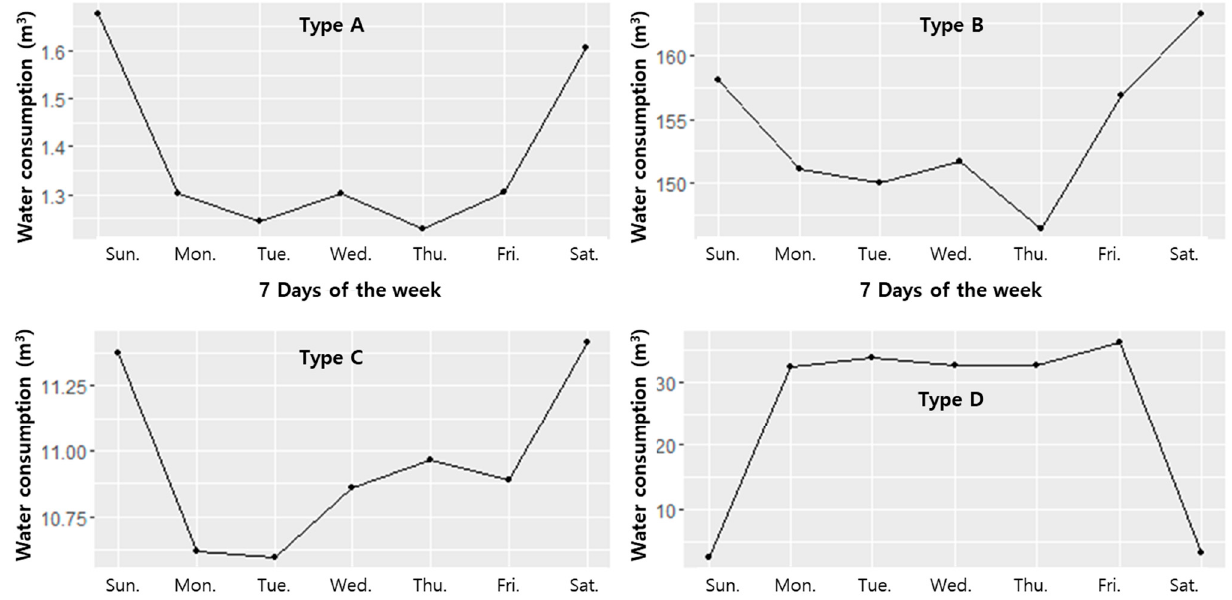
Figure 2. Water consumption pattern according to the days of the week.